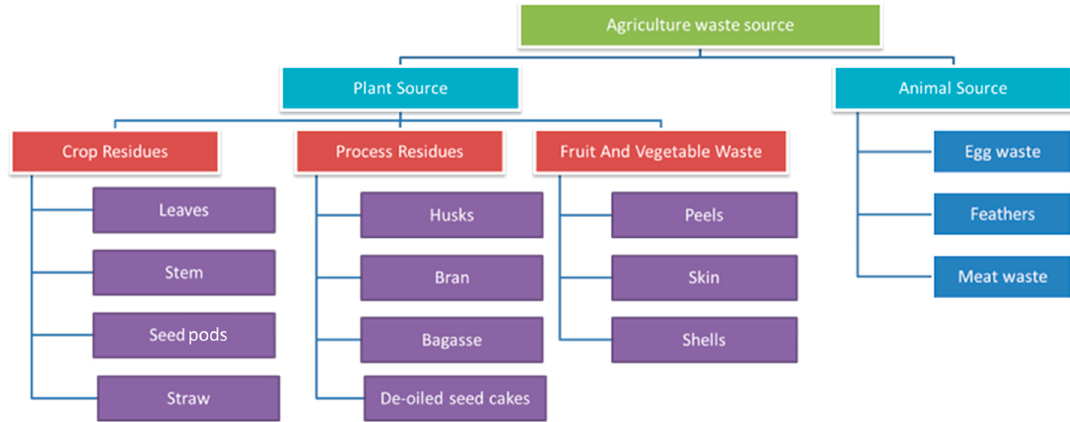
Figure 3. Various sources of agricultural